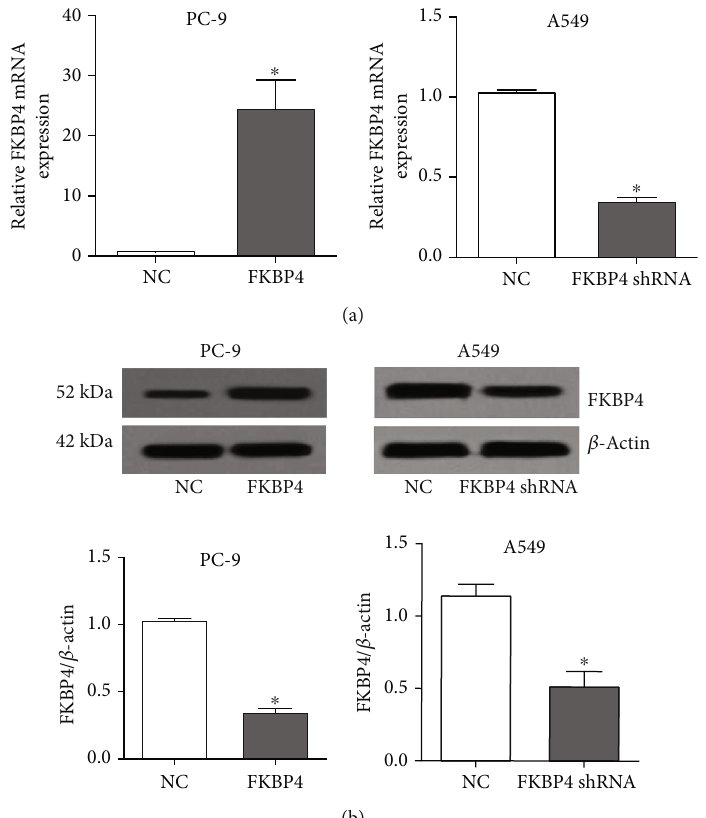
Figure 4: FKBP4 overexpression and silencing veri fi cation: (a) FKBP4 mRNA expression changes detected by qRT-PCR; (b) FKBP4 protein expression changes detected by western blot; N = 3 , ∗ P < 0 : 05 .